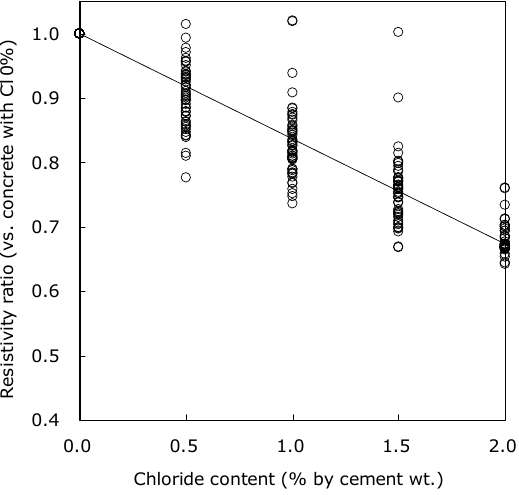
Figure 11 represents the variation in electrical resistivity depending on chloride concentration.